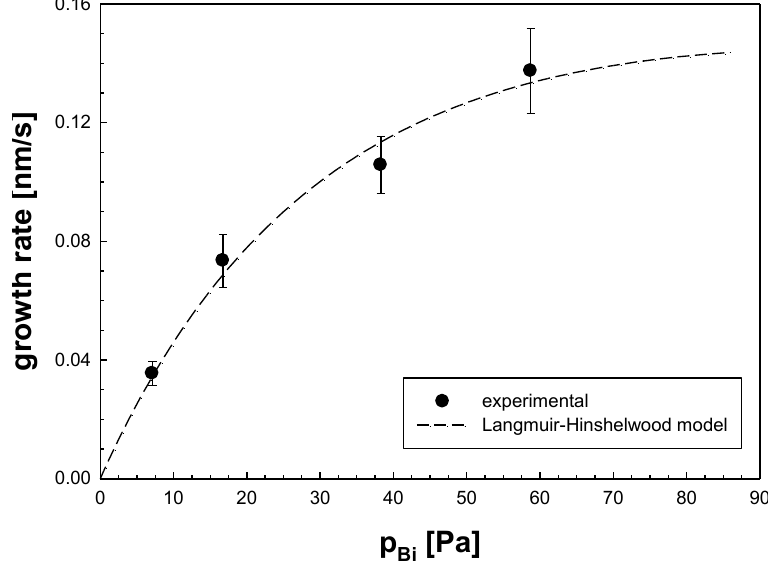
Figure 4. Arrhenius plot for CVD based growth rates of bismuth oxide films on silica particles generated freshly by CVS (black dots) and growth rates derived from Bedoya et al. [14] (grey dots). The data of Bedoya et al. were fitted with separate regression lines for the temperature ranges with and without significant homogeneous precursor decomposition.